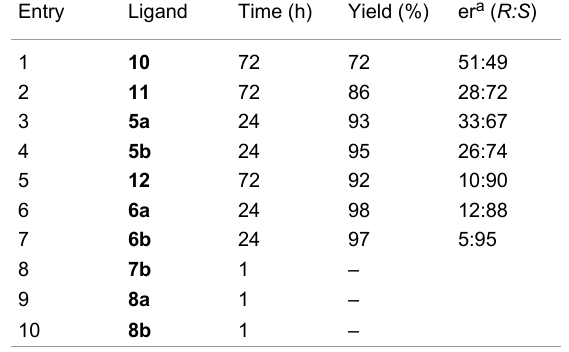
Table 2: Results of the Tsuji–Trost